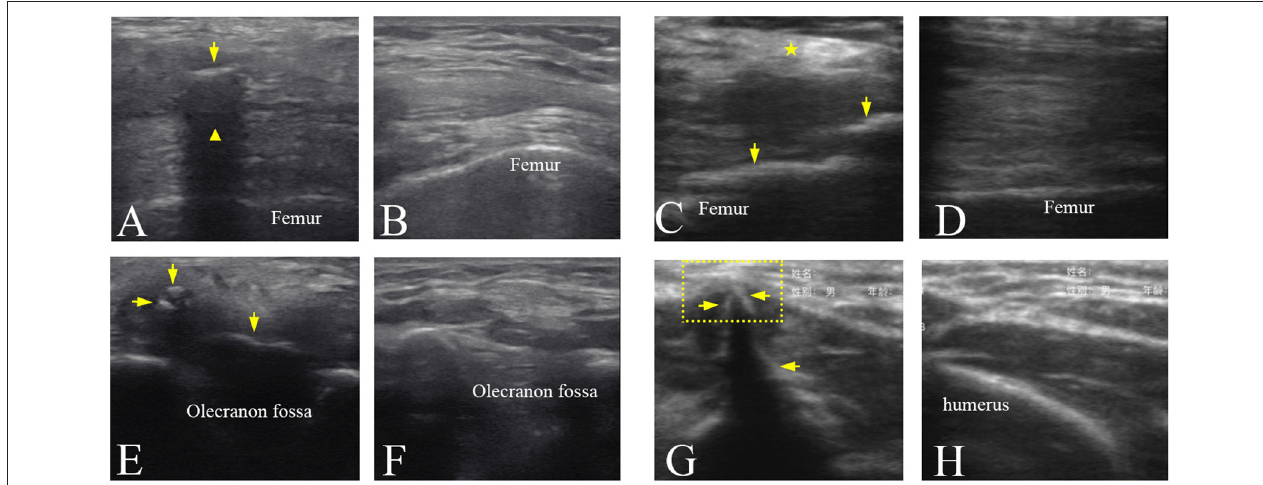
FIGURE 4 | Ultrasound images of the mature HO in the different joints. (A) Ultrasound image of the left knee joint of participant No. 3 showing that HO (arrow) with an acoustic shadowing ( ). (C) Ultrasound image of the right knee joint of participant No. 5 showing a hyperechoic area ( ) in the muscles and the HO tissues (arrows). (E) Ultrasound image of the right elbow joint of participant No. 4 showing the hypoechoic HO tissues (arrows) and loss of the textural structure of muscular fibers. (G) Ultrasound image of the right elbow joint of participant No. 6 showing local muscle evagination (dotted line box) by the hyperechoic HO tissues (arrows). (B,D,F,H) Ultrasound images of corresponding position of the uninjured side in (A,C,E,G), respectively.